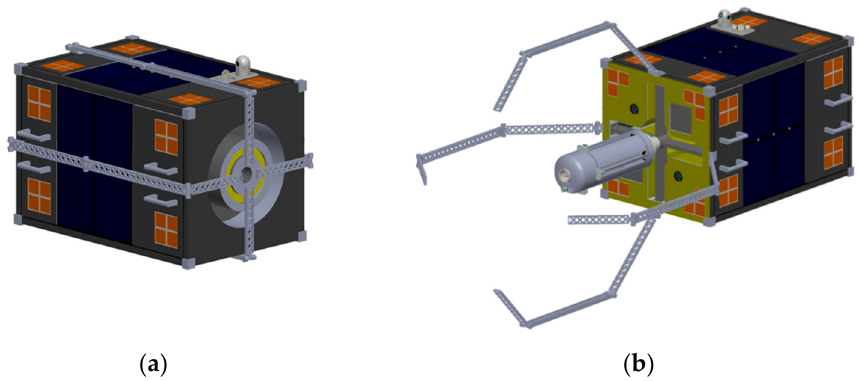
Figure 8. The robotic arm payload when the arms are ( a ) folded and ( b ) unfolded.